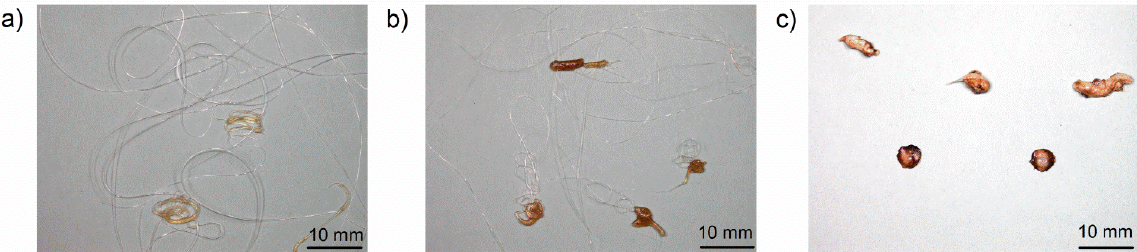
Figure 8. ( a ) Melt flow of PA 6 HB at a furnace temperature of 400 °C; ( b ) melt flow and drops of PA 6 HB at 550 °C; and ( c ) drop pathway of PA 6 V-2 at 550 °C. Table 6. Summary of melt dripping results for PA 6 HB, PA 6 V-2 and PA 6 V-0 at 600 °C.